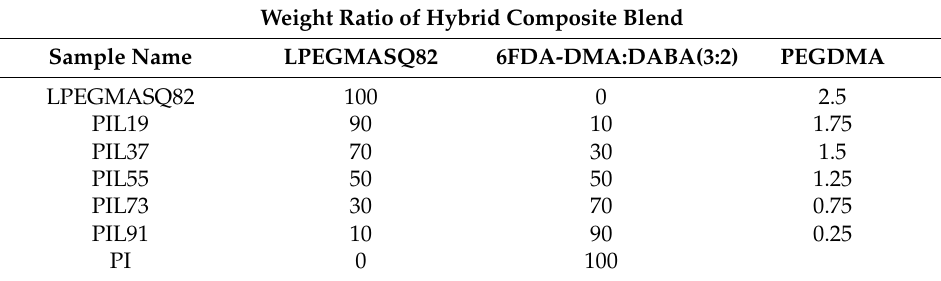
Table 2. Blend ratio of hybrid